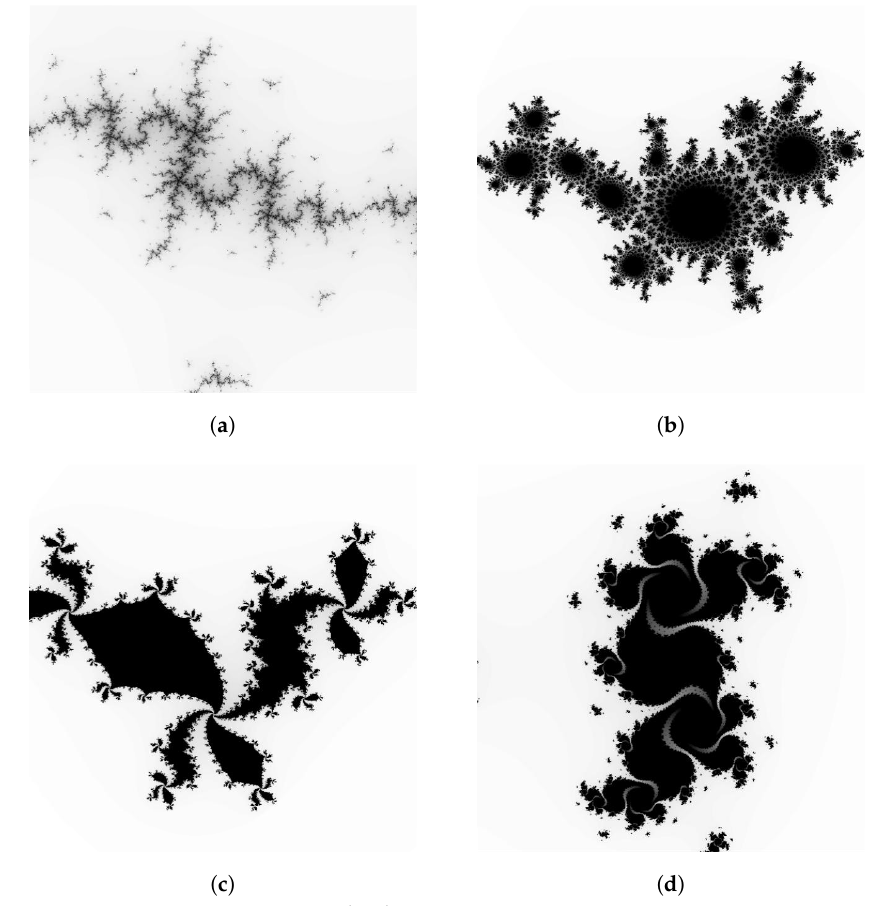
Figure 8. Julia sets of S S 4, p ,0.9 ( x ,1 ) if p = 0.8,0.6,0.4,0.2 iterating 128-times. ( a ) S S 4,0.8,0.9 ( x ,1 ) , c = − 1.44 − 3.8 i ; ( b ) S S 4,0.6,0.9 ( x ,1 ) , c = − 1.44 − 3.8 i ; ( c ) S S 4,0.4,0.9 ( x ,1 ) , c = − 1.44 − 3.8 i ; ( d ) S S 4,0.2,0.9 ( x ,1 ) , c = − 1.44 − 3.8 i